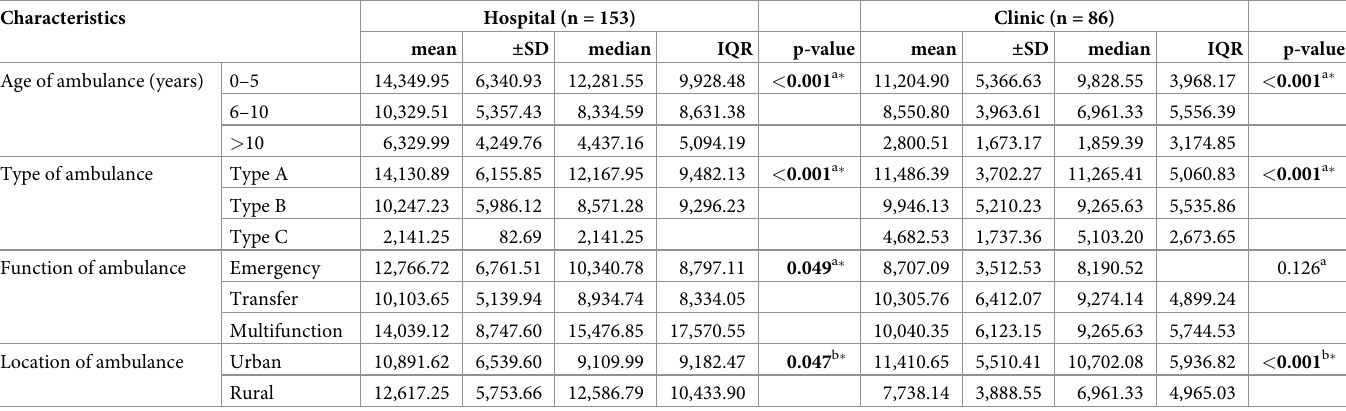
Table 6. Cost by ambulance characteristics (n =